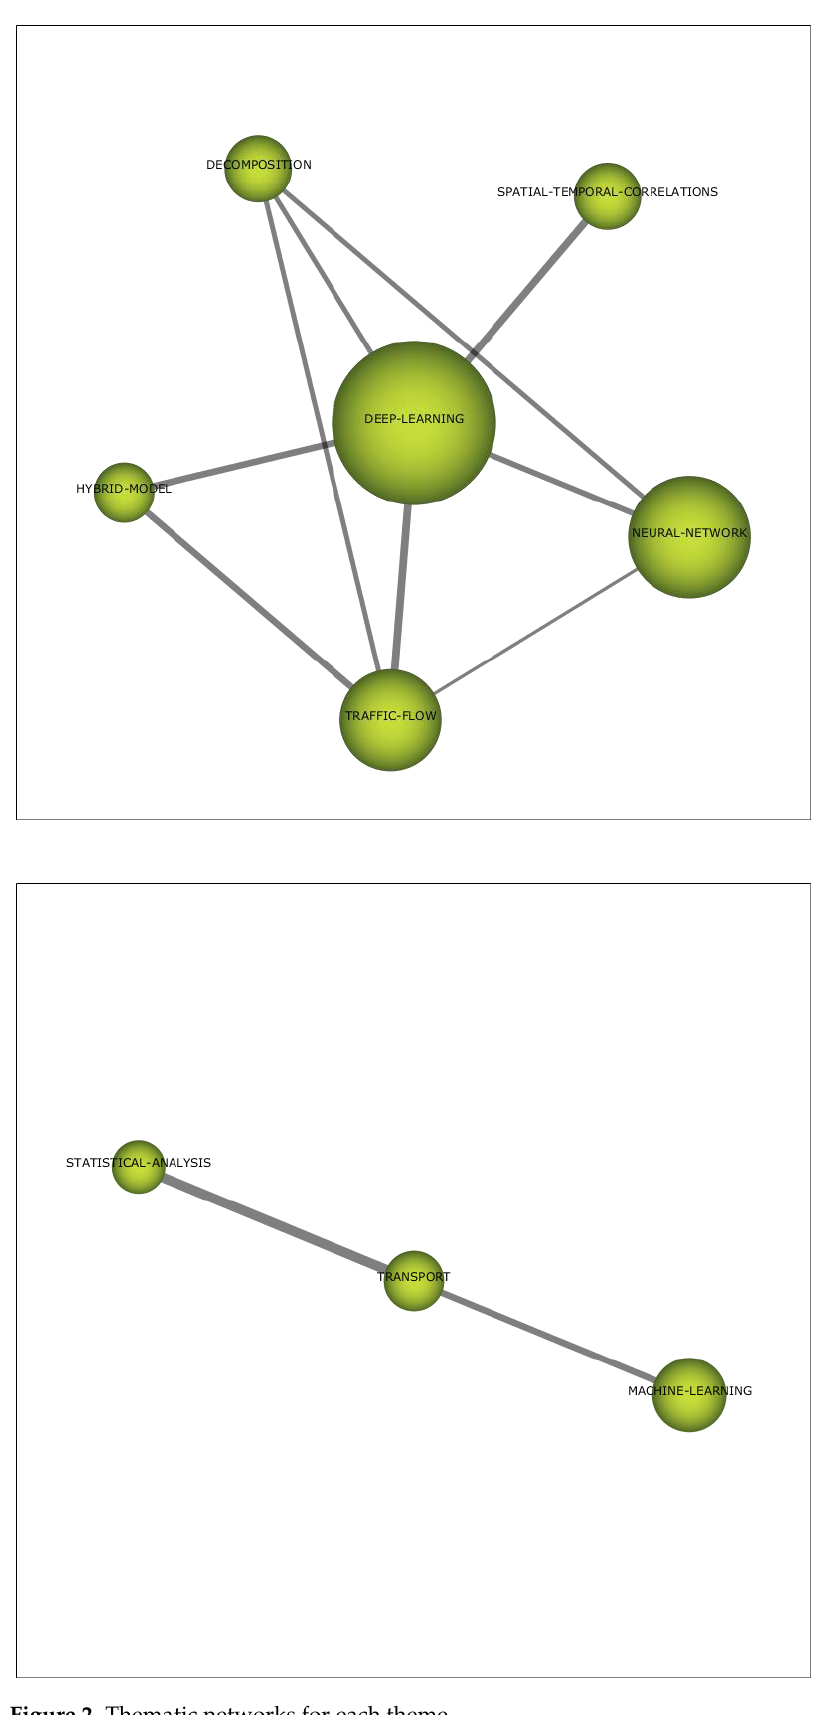
Figure 2. Thematic networks for each theme.